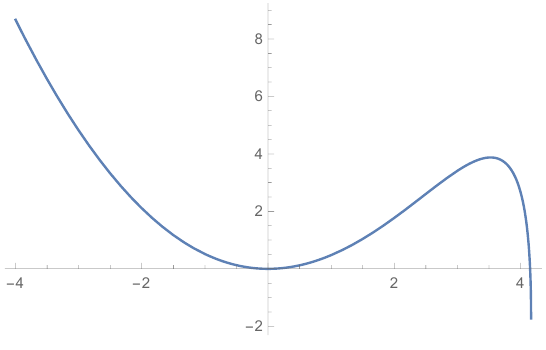
Figure 1 . The matrix model potential (4.1) at λ = 6 / 100 , M = 1 / 15